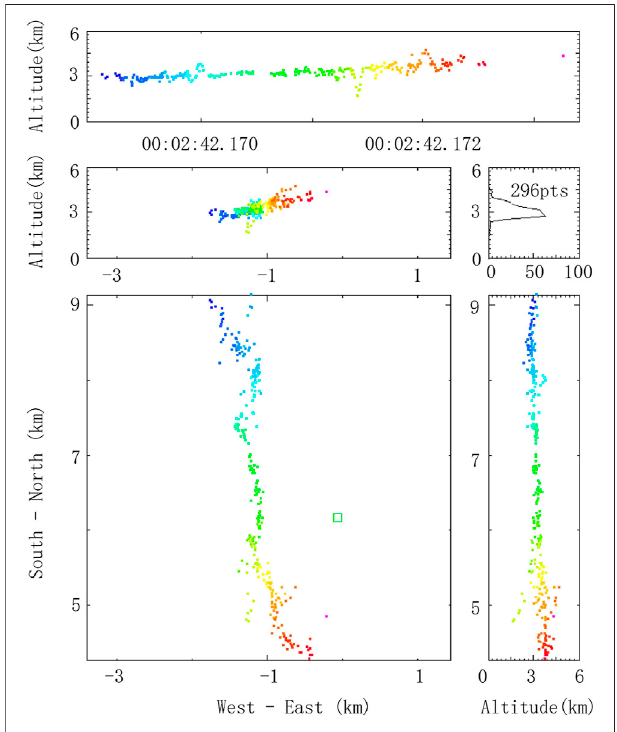
FIGURE 4 | Typical intra-cloud lightning discharges includes four RPBs (In this work, the time-variant of radiation sources marked by different colors from blue, green, yellow to red. The green square denotes the LMS station. The height versus time plot (the units of time are hour:minute:second: microsecond) exhibited in top panel; the north-south vertical projection exhibitedinmid-leftpanel;theheightdistributionofnumberofradiationevents exhibited in mid-right panel shows; the plan view exhibited in bottom-left panel; and the east-west vertical projections exhibited in bottom-right panel).